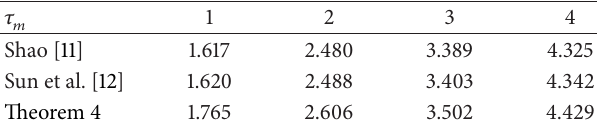
Table 2: Admissible upper bound 𝜏 𝑀 for various 𝜏 𝑚